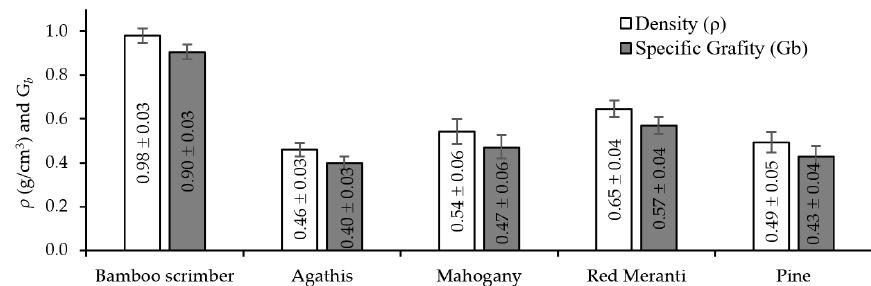
Figure 4. Density ( ρ ) and specific gravity ( G b ) of all specimens.